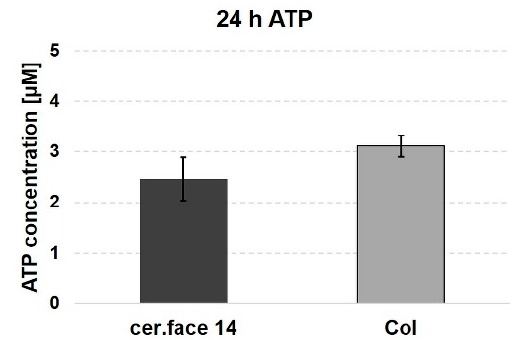
Figure 7. Adenosine triphosphate (ATP): the amount of energy-rich molecules in osteoblasts on ceramic (cer.face 14) is comparable with cells on collagen-coated surfaces (Col). Intracellular free ATP was detected via fluorometric ATP assay kit (Tecan Infinity 200). Statistics: Wilcoxon matched-pairs signed rank test, significance n.s. at p < 0.05, n = 3 (independent experimental approaches).